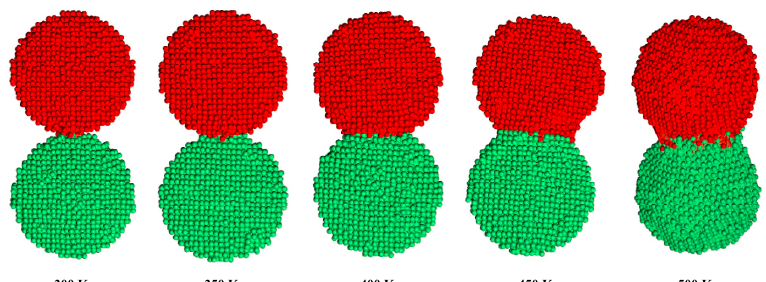
Figure 3. Molecular dynamics calculation of the sintered neck state of two nano-silver particles at different temperatures.